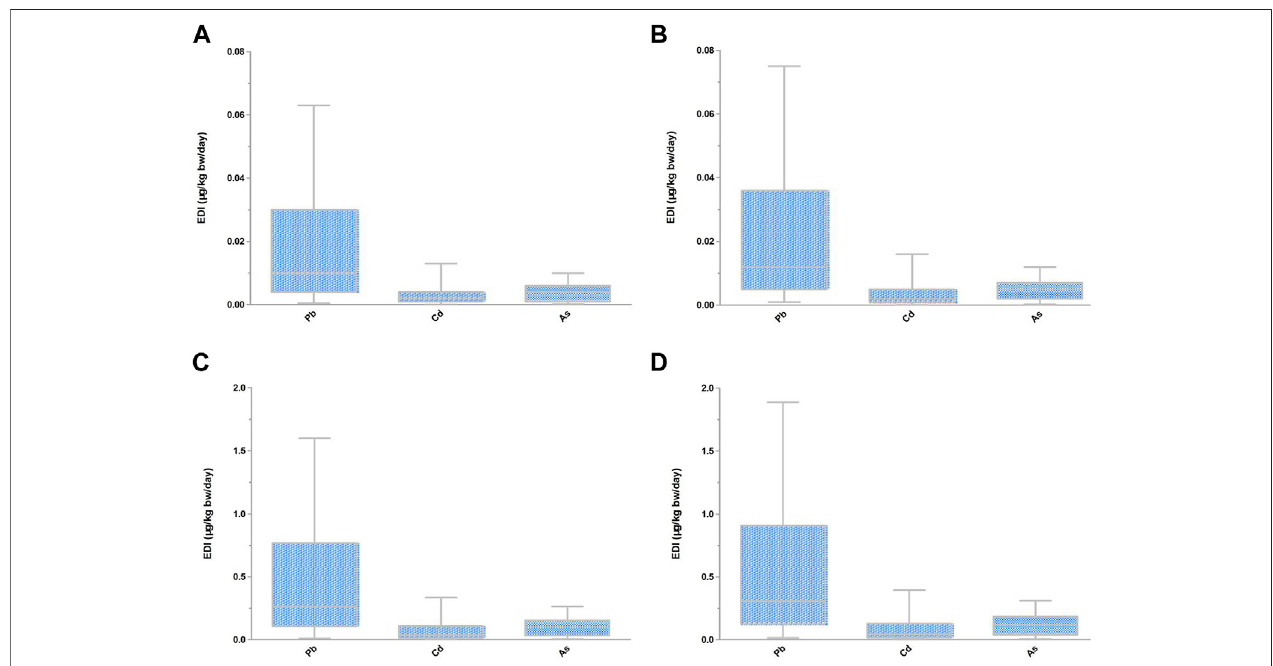
FIGURE1| EDIofheavymetalsinfoodhomologousTCM. (A) EDIofheavymetalsinfoodhomologousTCMusedasTCMformale. (B) EDIofheavymetalsinfood homologous TCM used as TCM for female. (C) EDI of heavy metals in food homologous TCM used as food for male. (D) EDI of heavy metals in food homologous TCM used as food for